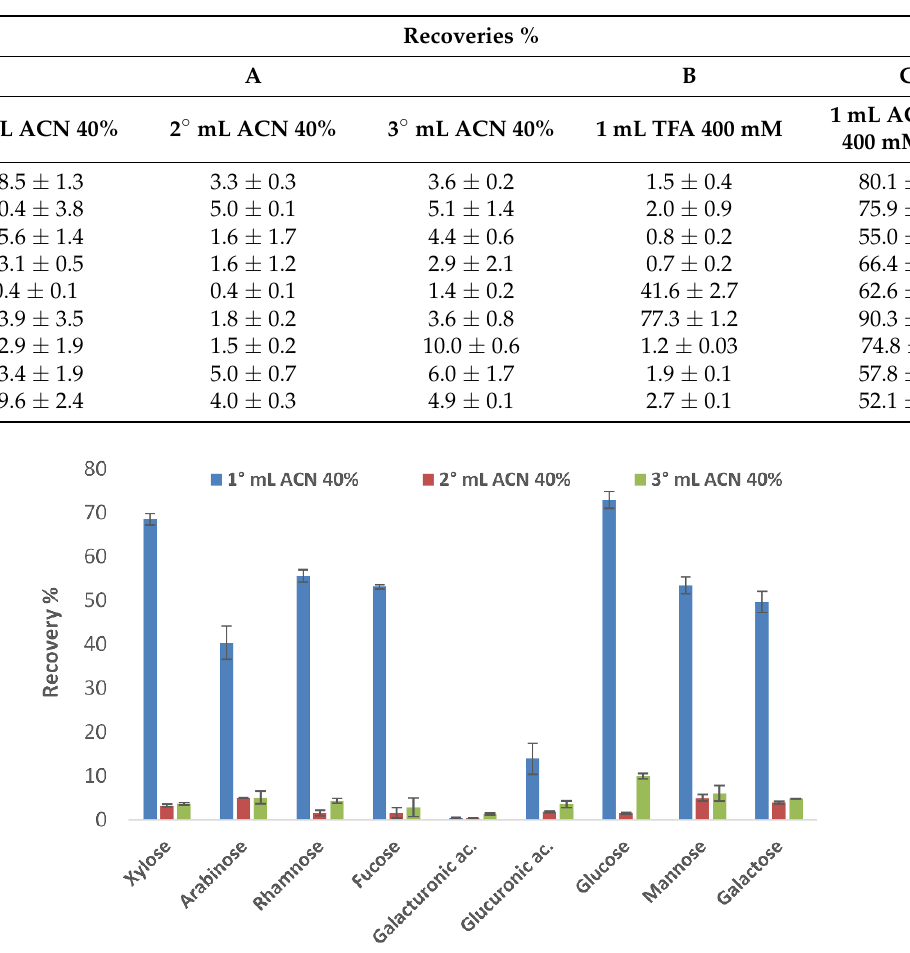
Figure 2. Recoveries, expressed as a percentage with respect to the concentration of starting solution, reported for each fraction of eluate analyzed, relative to the clean-up test results (Experiment A) using an SPE column applied to a standard solution of 7 monosaccharides and 2 uronic acids (each at 10 ppm). The experiment was conducted in triplicate and the error bars represent the confidence interval.